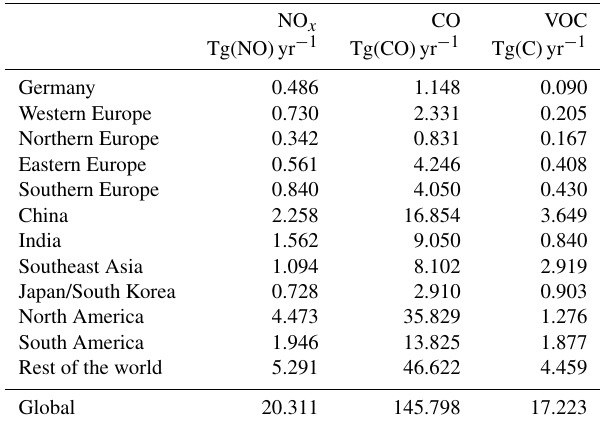
Table 1. Road traffic emissions per emission region for the year 2010 derived from the emission inventory MACCity (Granier et al., 2011). Global emissions are given in the last